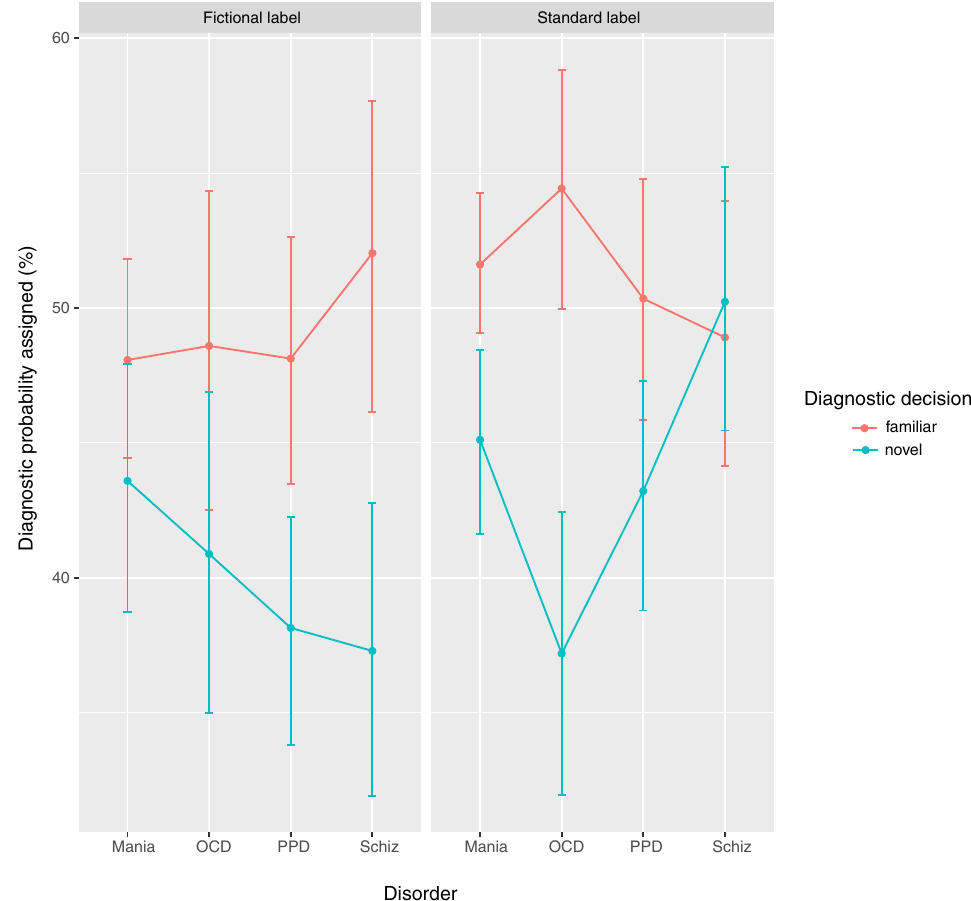
Fig. 3 Mean diagnostic probabilities (%) assigned to the diagnosis supported by familiar symptom (red) versus the diagnosis supported by novel symptom descriptions (blue) across diagnosis (mania/Blakins, OCD/Togastin, PPD/Patrase, schizophrenia/Ritners) for the standard-label and